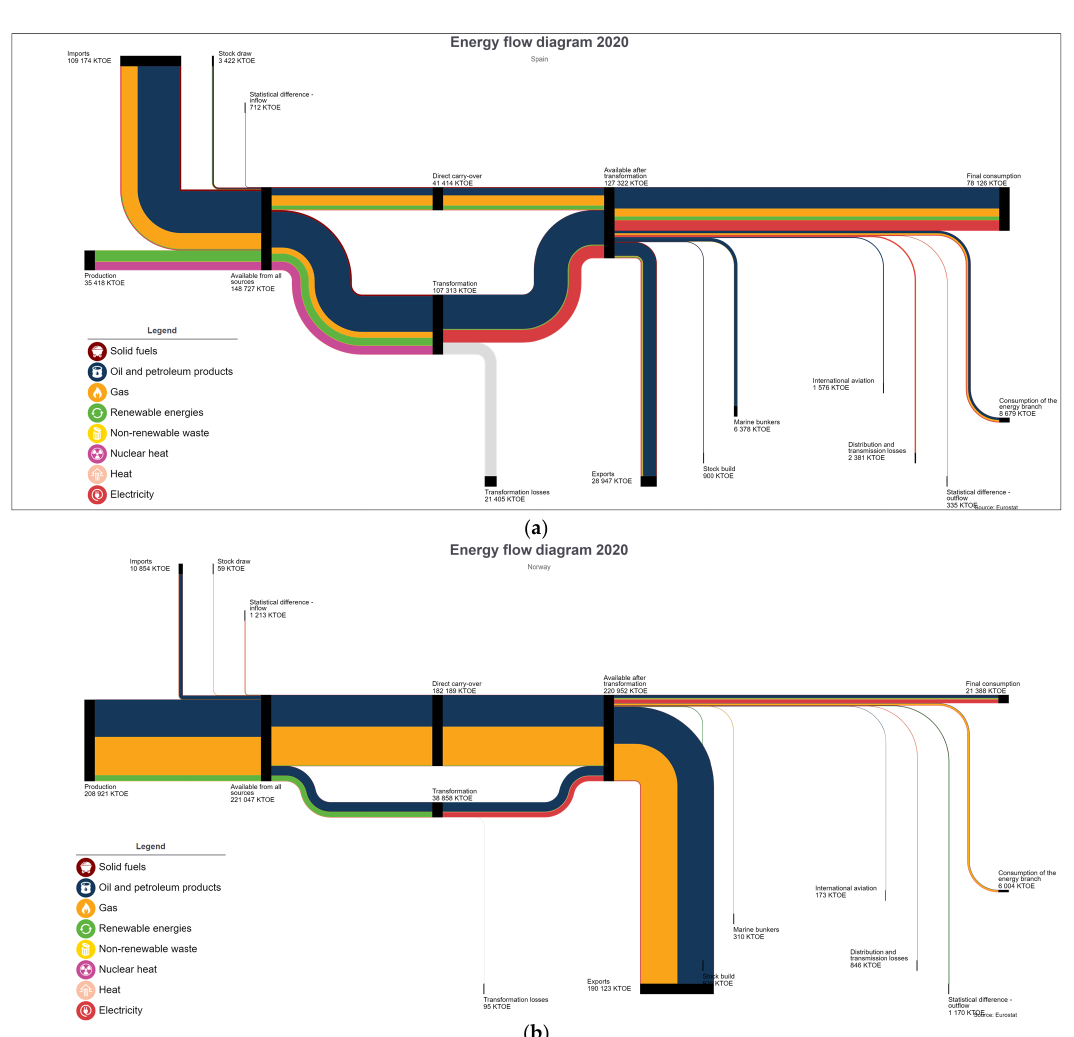
Figure 6. Energy Sankey diagram EU-27 2020, [45].